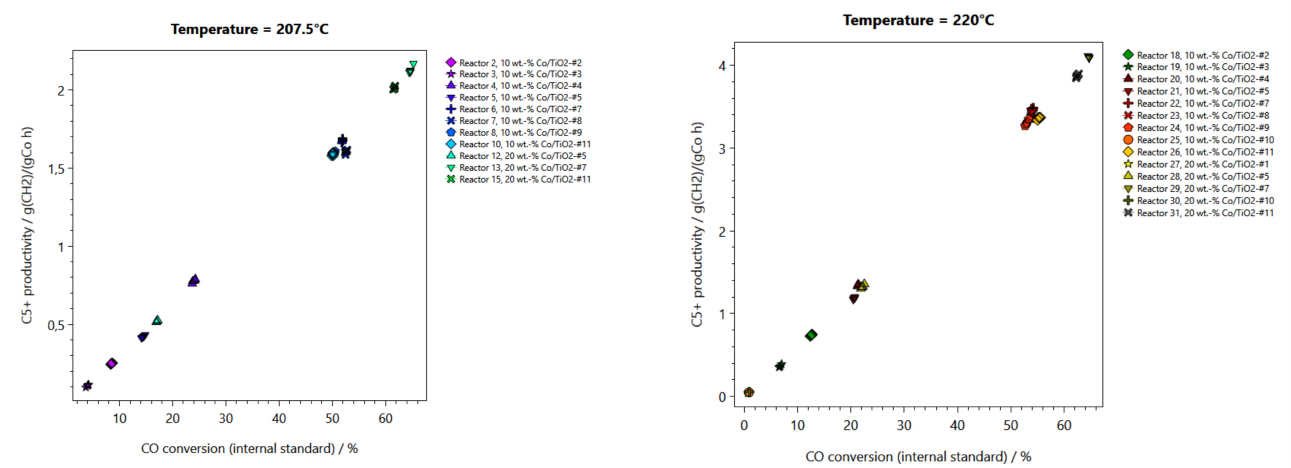
Figure 8. CH 4 selectivity and C 5+ productivity of all catalysts for two experimental